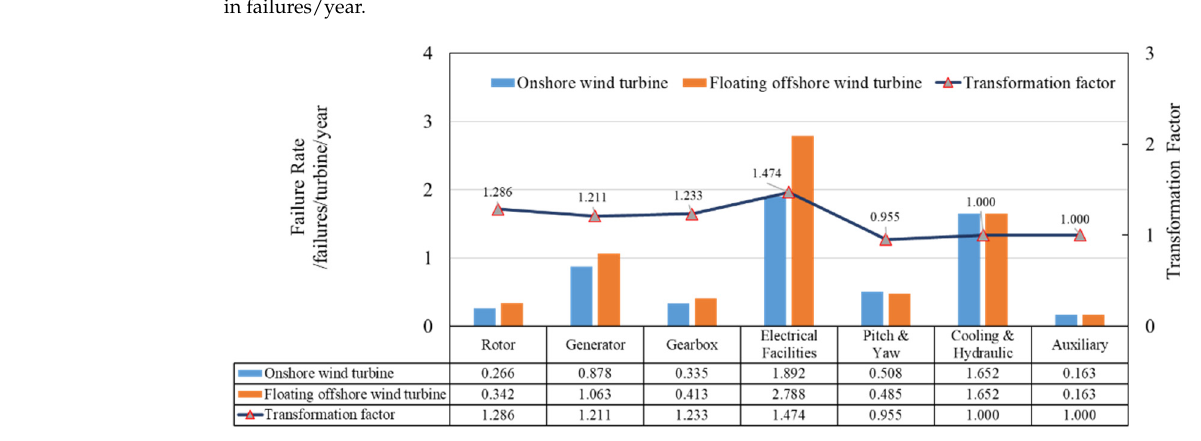
Figure 14. Failure rate transformation of components.